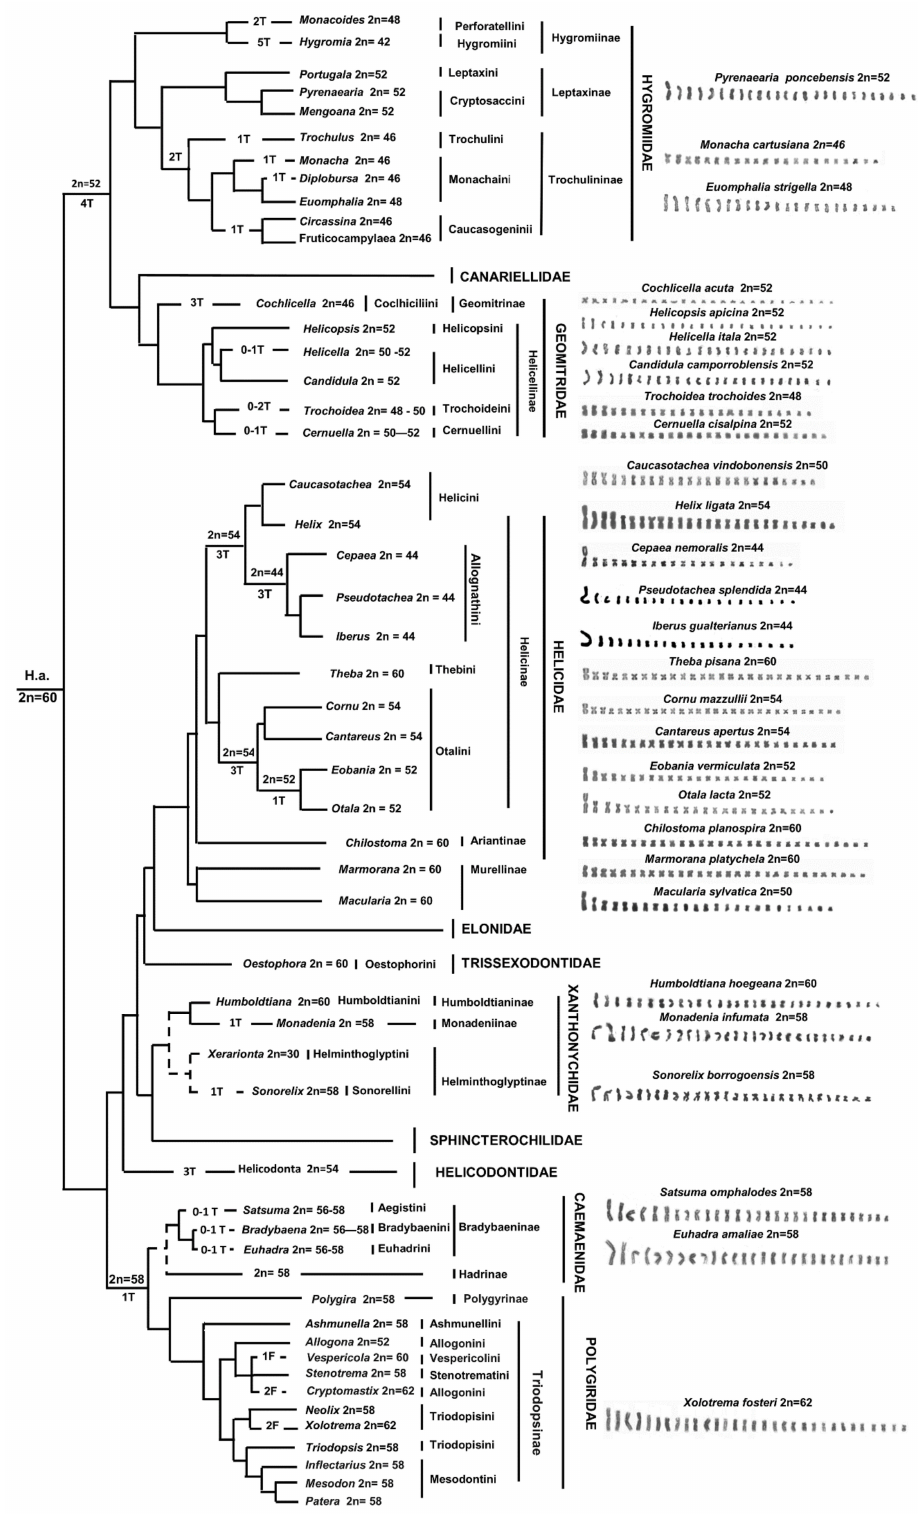
Figure 6. Phylogenetic tree of Helicoidea (redrawn from [9]) superimposed with our hypothesis on chromosome diversification in Helicoidea. Evolutionary relationships of Hygromiidae, Polygiridae, and Ariantine are from [13,14]. T = translocation; F = Fission. Dashed lines = uncertain relationships. Haploid karyotypes were redrawn from figures presented in the original papers (for References see Table S1; in particular, for Cepaea nemoralis , for which two formulas are given, the presented haploid karyotype is from